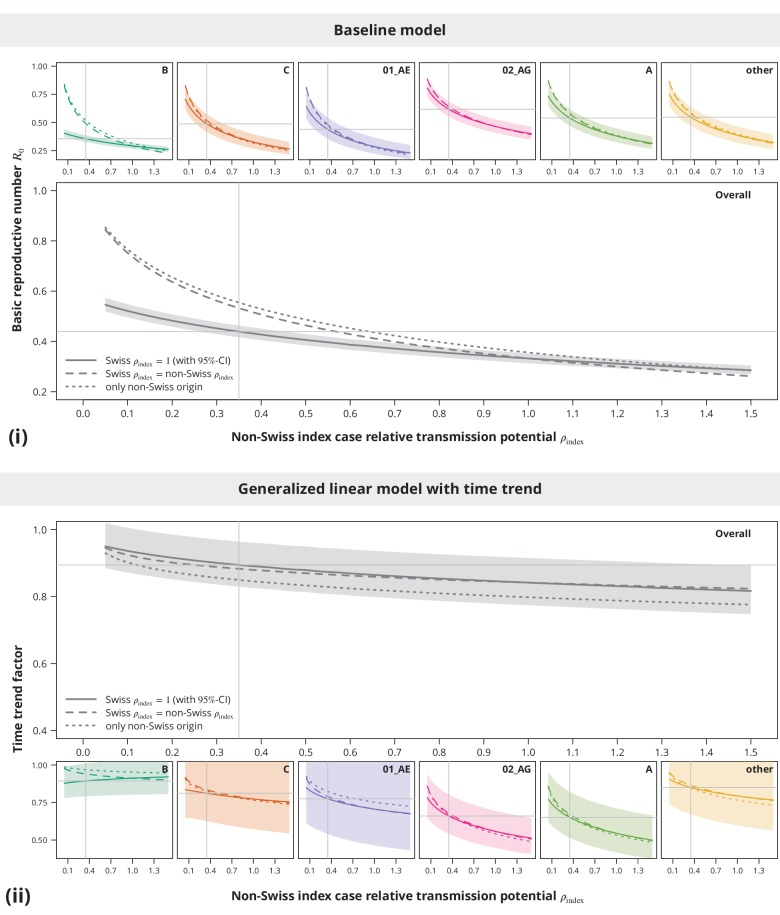
Sensitivity analysis regarding the index case relative transmission potential.Panel (i) shows the sensitivity of the R0 estimates from baseline model and panel (ii) the sensitivity of the time trend factor. The colored lines represent the subtype-stratified analyses, while the results from the overall models are shown in gray. In the first sensitivity analysis, the ρindex of Swiss-originating transmission chains was held at 1 and the ρindex of non-Swiss origin varied (solid lines). In the second analysis, the ρindex of Swiss and non-Swiss origin was the same (dashed lines). The dotted lines show the results from the sensitivity subanalysis including only the transmission chains of non-Swiss origin. The vertical and horizontal lines depict the parameters and estimates from the main analysis, respectively.